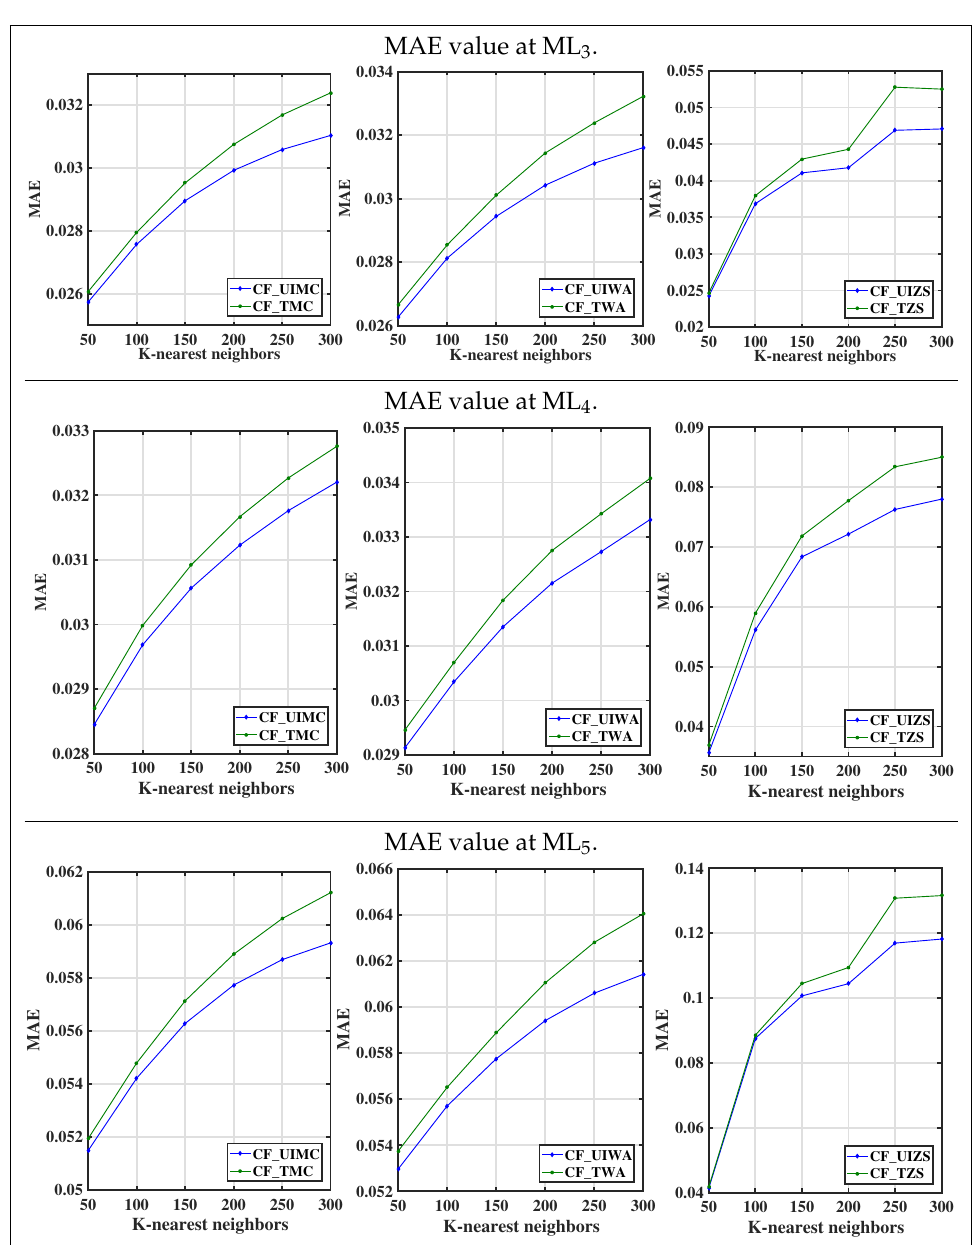
Figure 3. MAE Value at